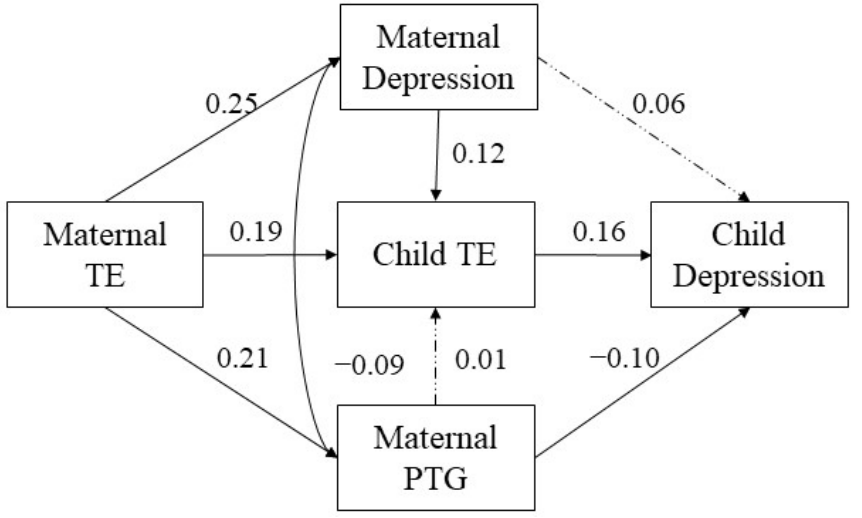
Figure 1. Multiple indirect effect model. Note. Standardized coefficients are reported. Solid lines represent significant paths, and the dashed line represents an insignificant path. TE: trauma exposure; children’s perceived impact: children’s perceived impact of the earthquake on their family; PTG: posttraumatic growth.